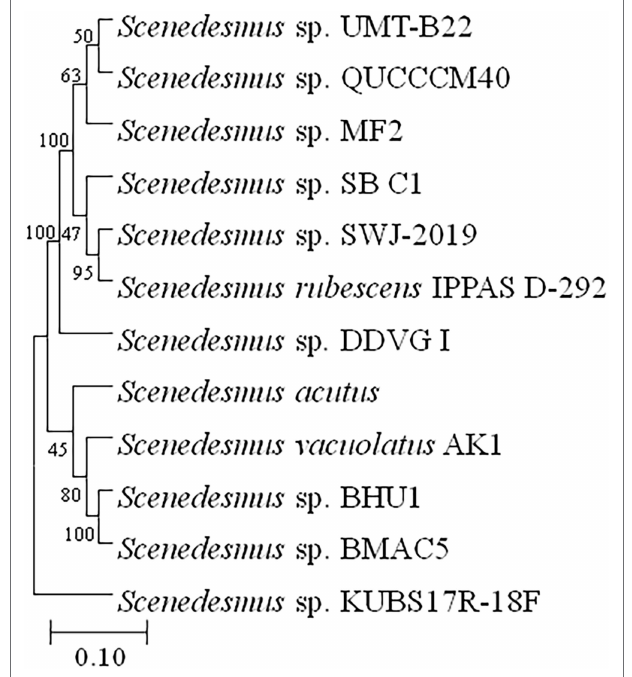
FIGURE 3 | Phylogenetic tree and evolutionary relationships of microalga Scenedesmus sp. BHU1 based on 18S rDNA gene sequence. The boot strap consensus tree was created using the MEGA 11 software and multiple sequence alignment with the neighbor-joining